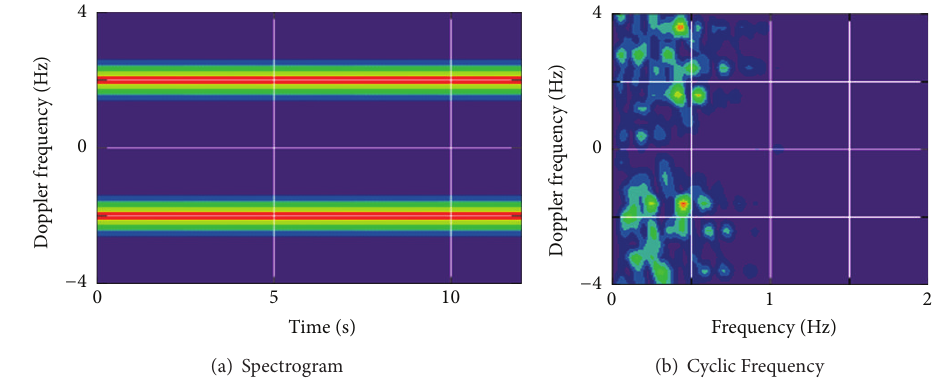
Figure 5: The simulation results with a displacement period of 0.5 s.